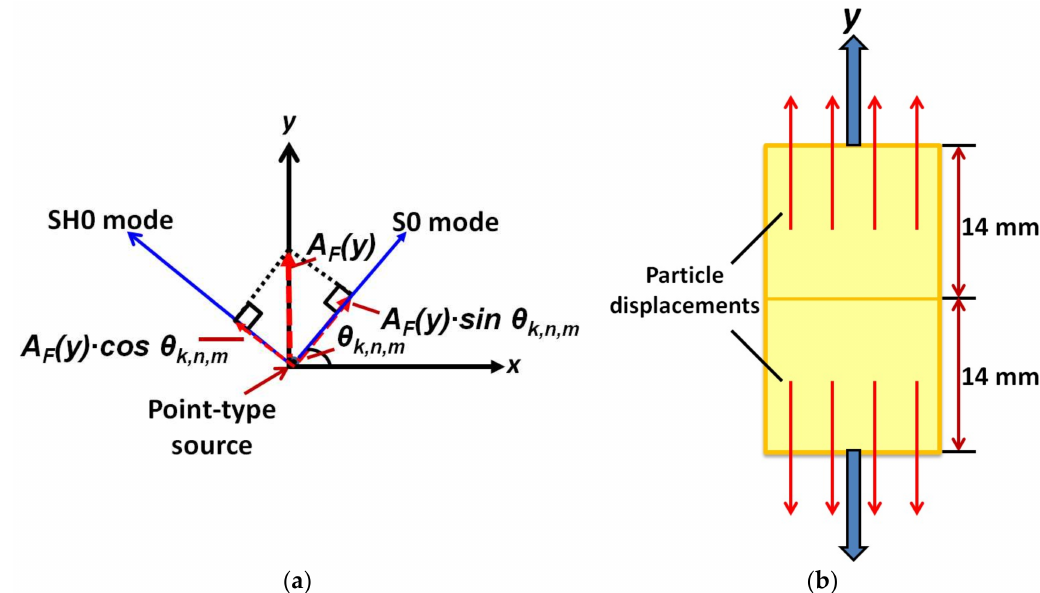
Figure 4. Calculation of correction factor ( C F ) for P1-MFC transducer: The particle displacements in excited P1-type MFC transducer ( a ), The correction factor C F (multiplication of the amplitude factor ( A F ) and direction factor for a specific GW mode (A0 or S0)) ( b ).